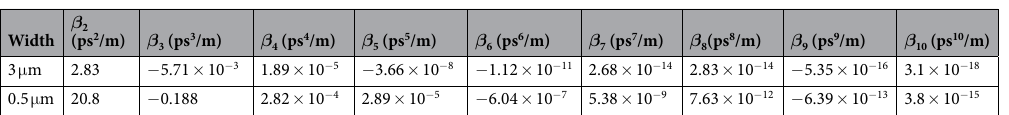
Table 2. β n at 1550 nm.